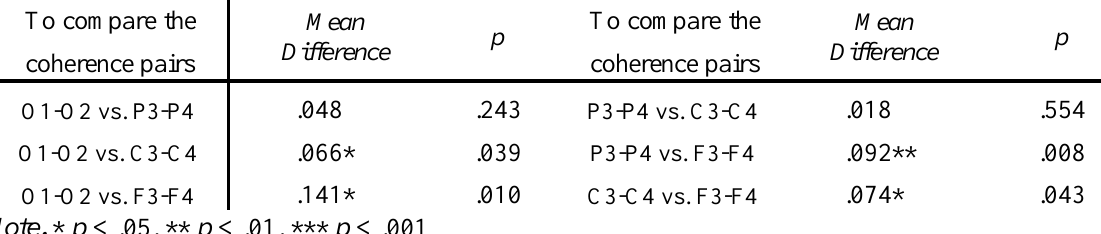
Table 9. LSD post hoc tests applied to compare the difference of coherence strength between anterior posterior inter hemispheric electrode pairs